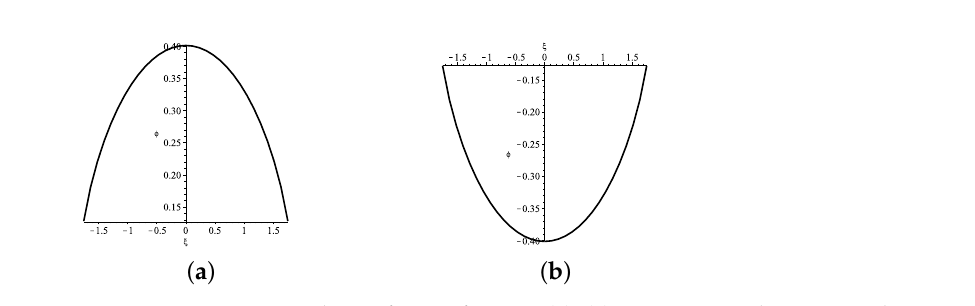
Figure 28. Compactonsolution forms of system (5). ( a ) Compacton solution given by Equation (70) + . ( b ) Compacton solution given by Equation (70) − .